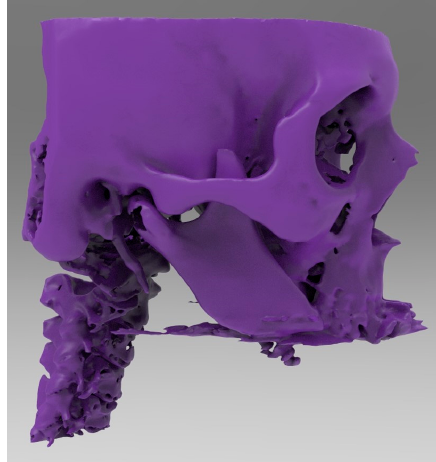
Figure 3. 3D reconstruction of the mandibular branches displaced due to the temporal contraction.